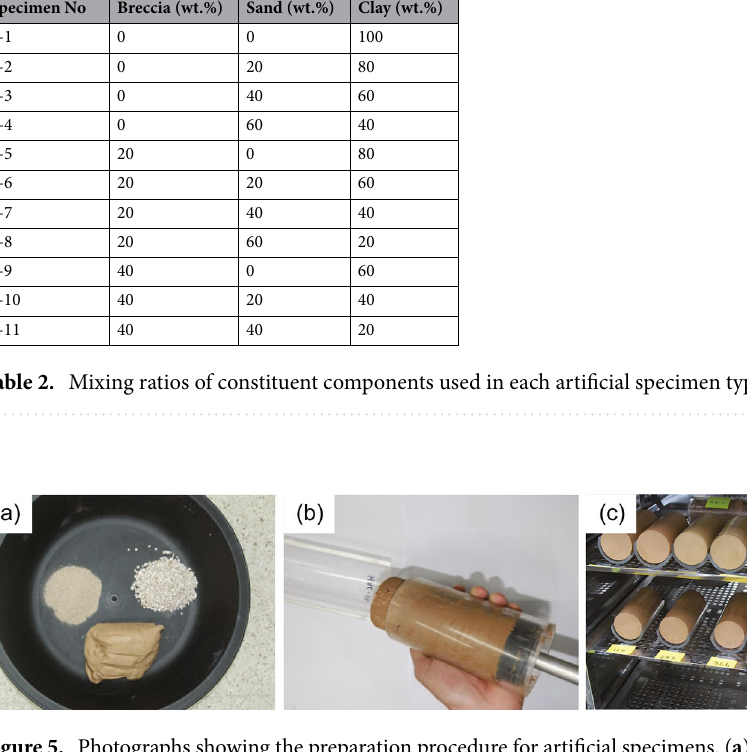
Figure 5. Photographs showing the preparation procedure for artificial specimens. ( a ) Constituent components (breccia, sand, and clay) ready for mixing. These materials were mixed with water according to the mixing ratios given in Table 2. ( b ) Cylindrical specimens formed using acrylic tubes. ( c ) Artificial specimens being dried at 40 ℃ for various durations (0, 12, 24, 36, 48, or 72 h) to produce specimens with different water